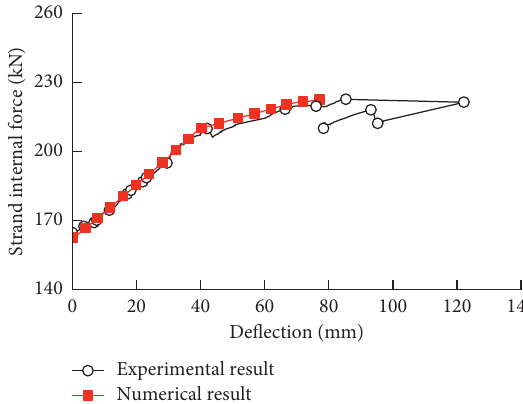
Figure 5: Failure mode of FE model S0.